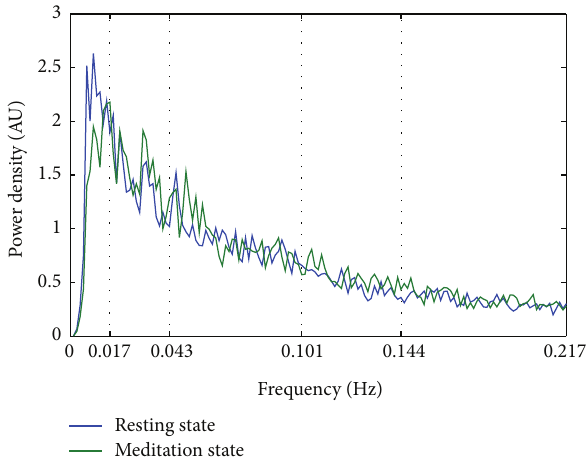
Figure 4: Mean power spectral density of the Default Mode Network (DMN) component. The peak power density was observed below 0.04 Hz for both conditions (resting state and meditation state). AU stands for arbitrary